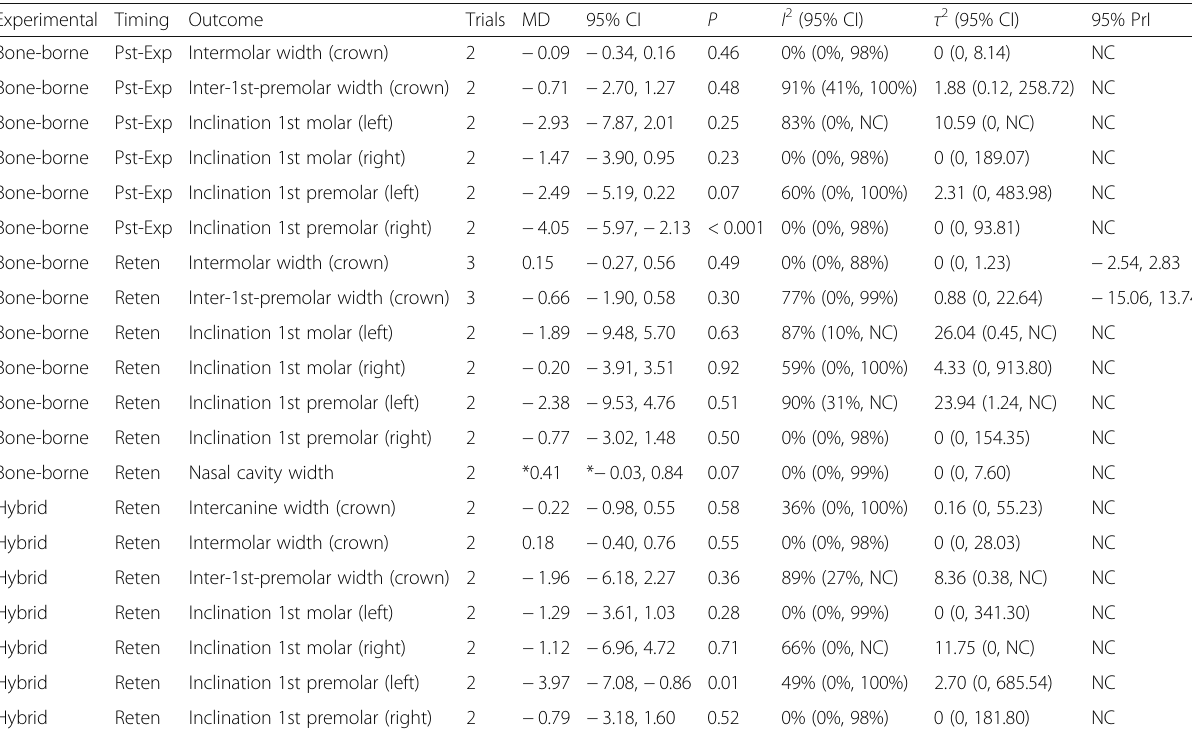
Table 3 Results of random effects meta-analyses performed from randomized trials comparing tooth-borne rapid maxillary expansion with either bone-borne or hybrid (tooth-bone-borne) rapid maxillary